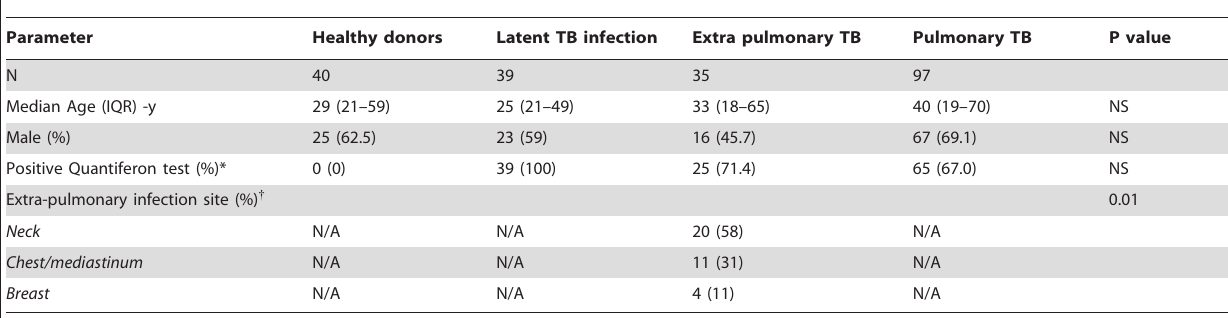
Table 1. Demographic characteristics of the study